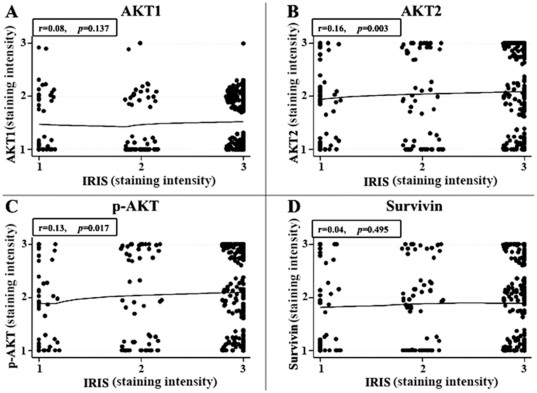
Correlations between BRCA1-IRIS expression and AKT1, AKT2, p-AKT and survivin in breast tumor samples.Nonparametric Spearman rank correlation test comparing BRCA-IRIS and AKT1, AKT2, p-AKT, and survivin on 326 breast tumors TMAs. The staining for each marker was scored as described in the text and the results were blotted. Insets show Spearman correlation coefficient (r) and p-value for each correlation.